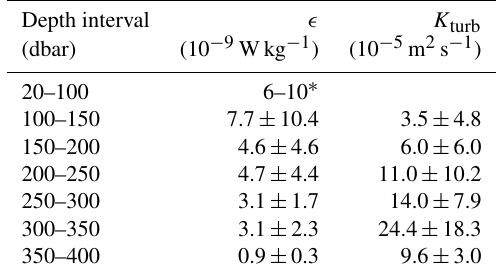
Table 2. Lookup table for turbulent kinetic energy dissipation rates and vertical eddy diffusivity derived from a Thorpe-scale-based pa- rameterization and applied to the full-resolution CTD profiles of the cruise PEACETIME collected in the Algerian Basin and in the central Tyrrhenian Sea. The methodological approach described by Park et al. (2014) has been strictly followed, by averaging in 50m bins over the 13 profiles represented in Figs. 3 and 7. For surface values ( ∗ ), the range of estimation proposed by Cuypers et al. (2012) is